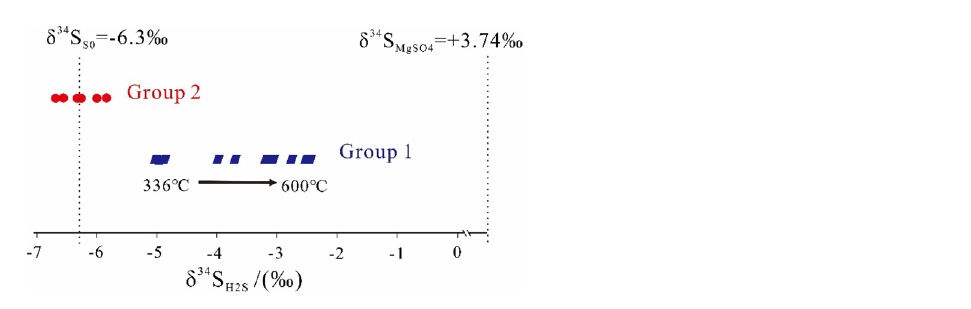
Figure 4. The 34 S isotopic ratios of H 2 S in hydrothermal experiments involving S 0 , MgSO 4 and CaSO 4 ·2H 2